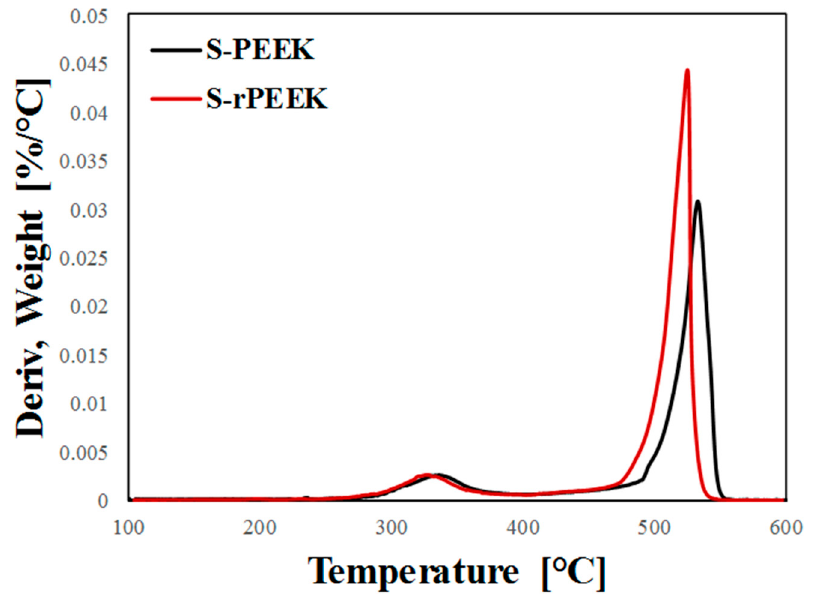
Figure 2. Thermo-gravimetric plot of derivative weight vs. temperature of S-PEEK and S-rPEEK polymer in the range 100–600 °C.